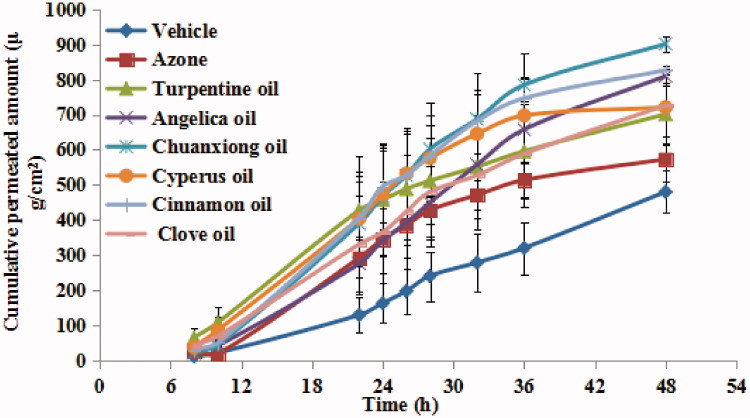
Permeation profiles of ibuprofen with 3% w/v EOs through excised rat skin (n = 5).